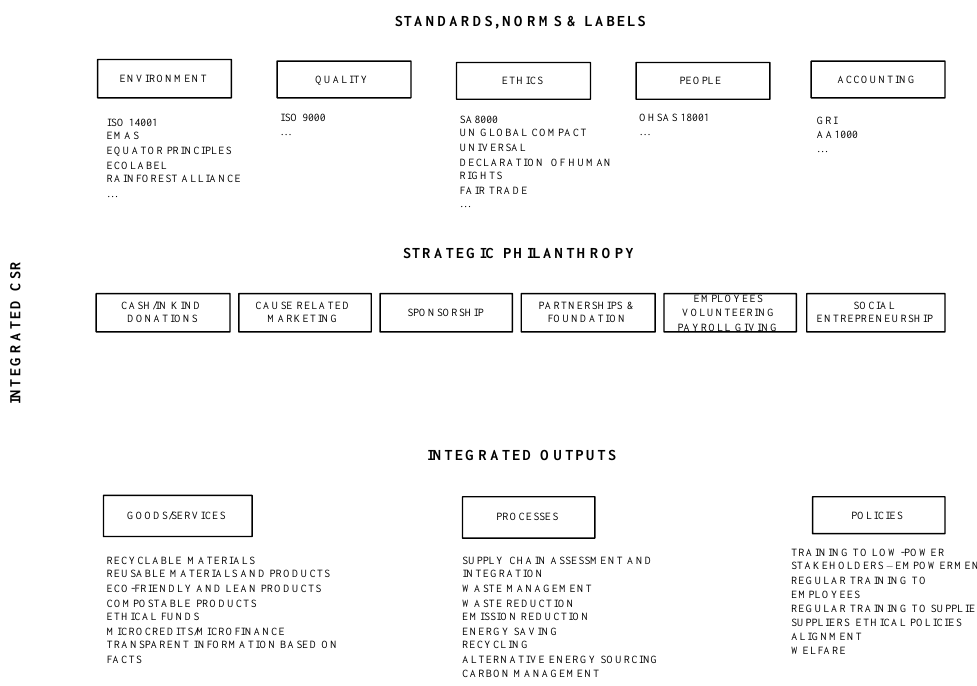
Figure 1: Framework of Integrated